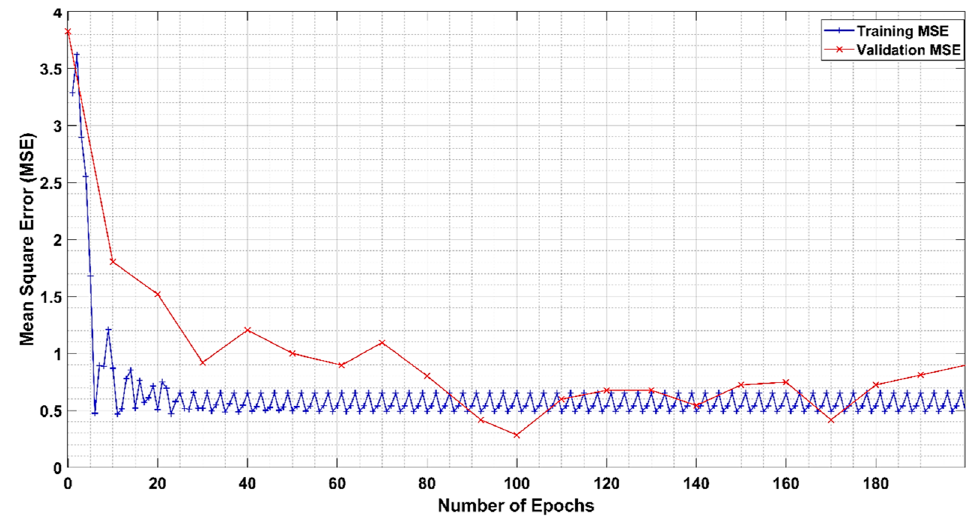
Figure 7. Minibatch error for network training.